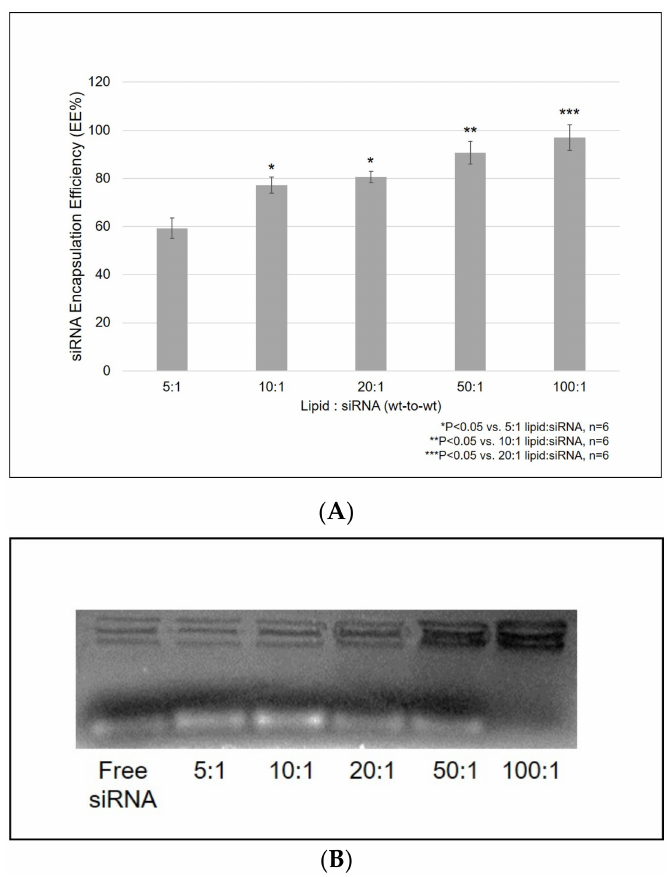
Figure 4. ( A ) Increasing lipid:siRNA (wt-to-wt) ratios enhanced R8-PLP siRNA EE% while ( B ) gel exclusion assays ran on unpurified liposome samples served as physical confirmation of increasing siRNA